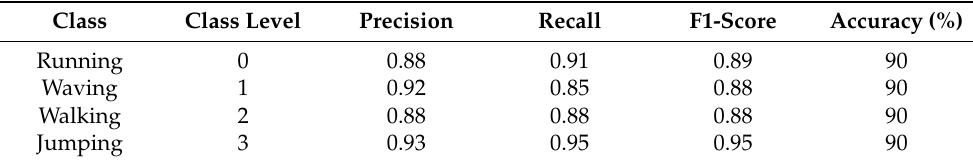
Table 2. Precision, recall, and F1 score for all classes, labeled